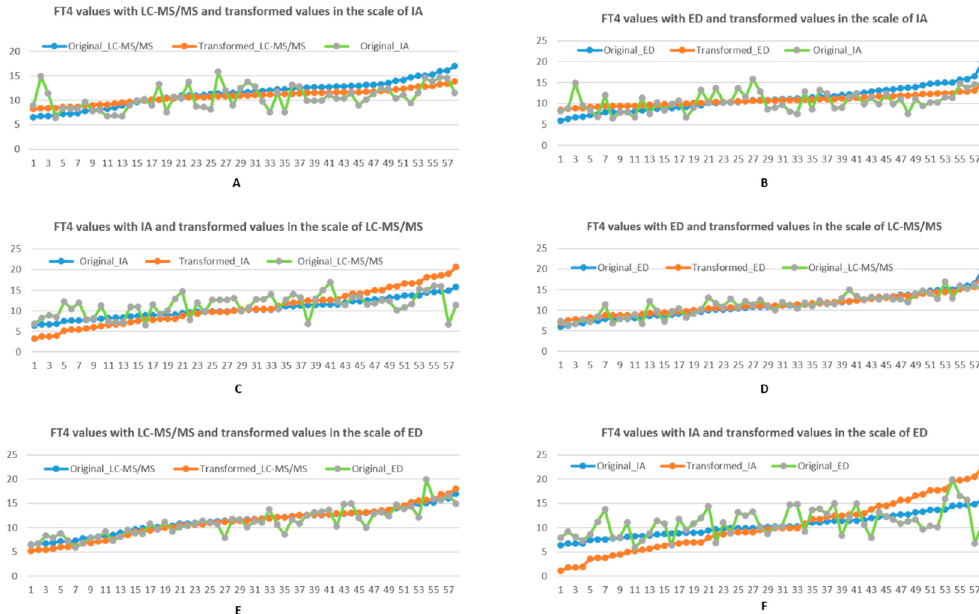
Table 5. Mean, SD and CV of FT4 transformations into ED scale by linear transformation.